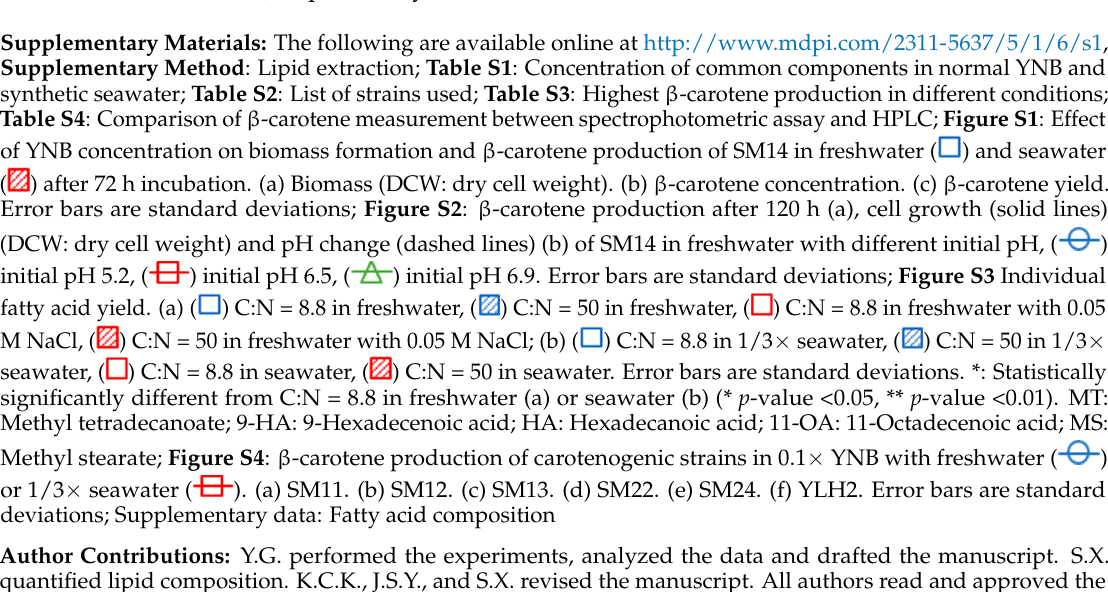
significantly different from the control (no NaCl) (* p -value < 0.05, ** p -value < 0.01).